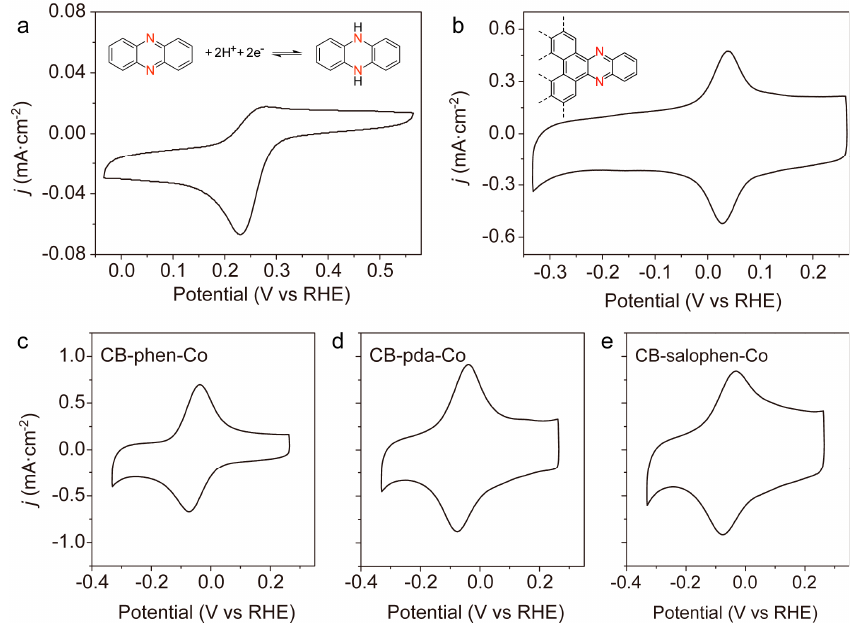
Figure 5. CV curves of ( a ) dissolved phenazine molecules, ( b ) CB-conjugated benzene, ( c ) CB-phen- Co, ( d ) CB-pda-Co and ( e ) CB-salophen-Co in Ar saturated solution of 0.1 M KOH. The sweeping rate is 10 mV·s − 1 . Table 2. Comparison of the total density of Co sites from ICP-MS analysis and electrochemically active Co sites from CV curves (unit: nmol·cm -2 ).